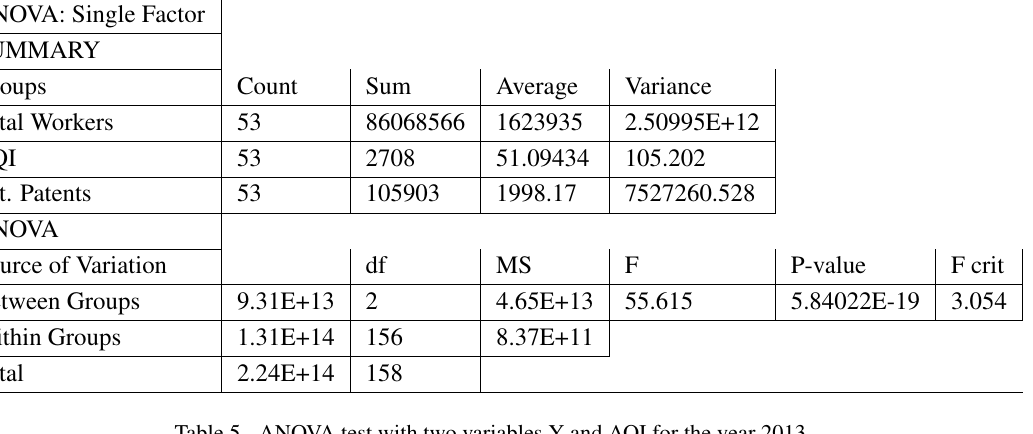
Table 5. ANOVA test with two variables Y and AQI for the year